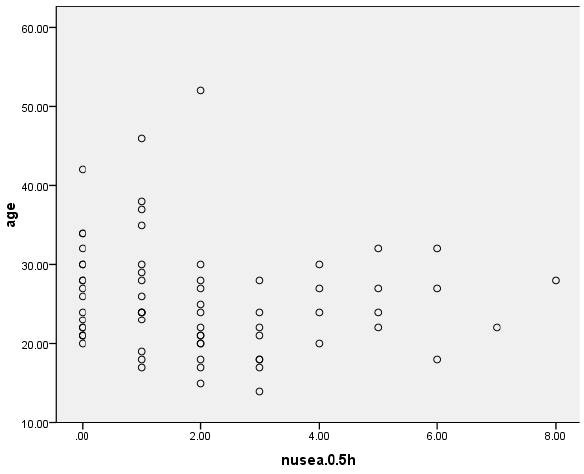
Figure 3. The relationship between age and nausea severity 30 minutes after charcoal consumption. * Pearson correlation test was used.